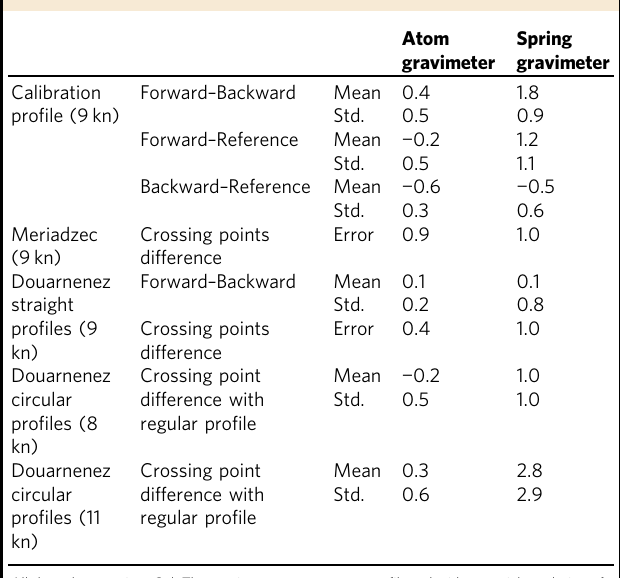
Table 1 Gravimeters results and comparison